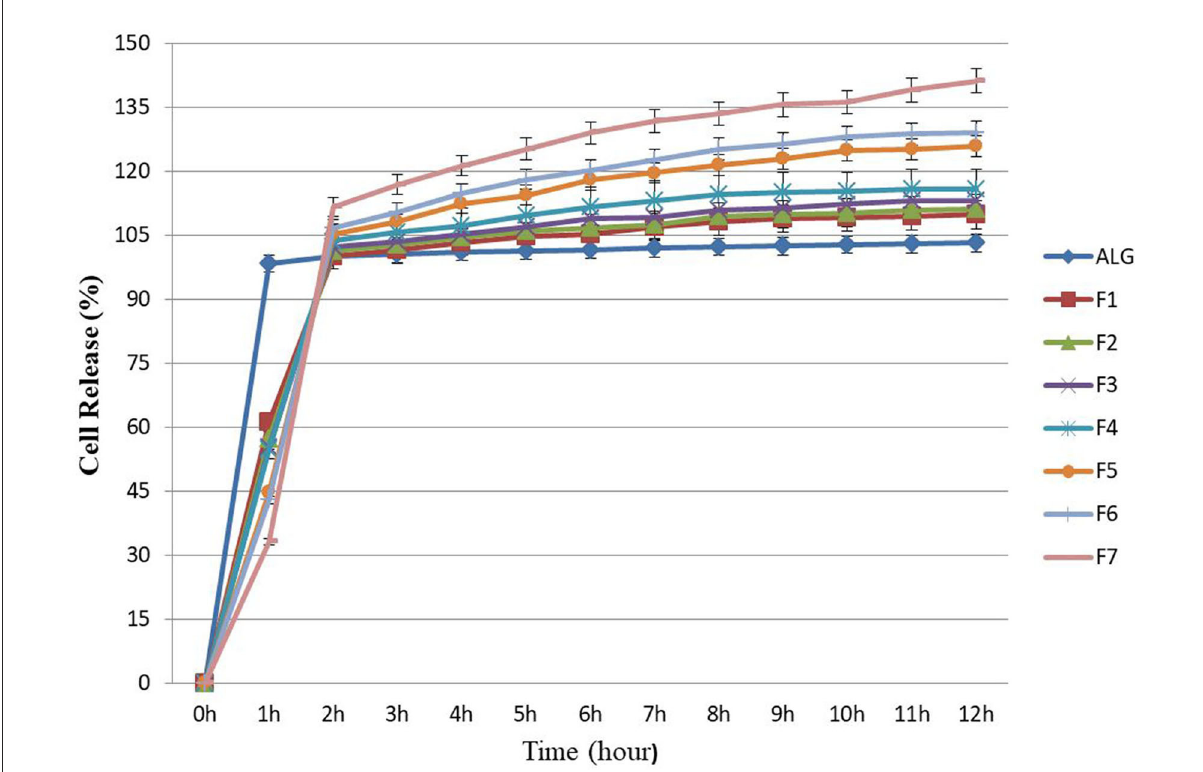
FIGURE2 Releasing rates of microencapsulated E. faecium with different gel formulations at simulated intestine pH solution containing digestive enzymes for each hour (up to hour 12). ALG: alginate-encapsulated cells (control). F1: ALG (0.6%) + PG (0.2%); F2: ALG (0.6%) + PG (0.2%) + FOS (0.2%); F3: ALG (0.6%) + PG (0.2%) + FOS (0.3%); F4: ALG (0.6%) + PG (0.2%) + FOS (0.4%); F5: ALG (0.6%) + PG (0.2%) + Fk (0.2%); F6: ALG (0.6%) + PG (0.2%) + Fk (0.3%); F7: ALG (0.6%) + PG (0.2%) + Fk (0.4%). Values shown are means ± standard deviations ( n =